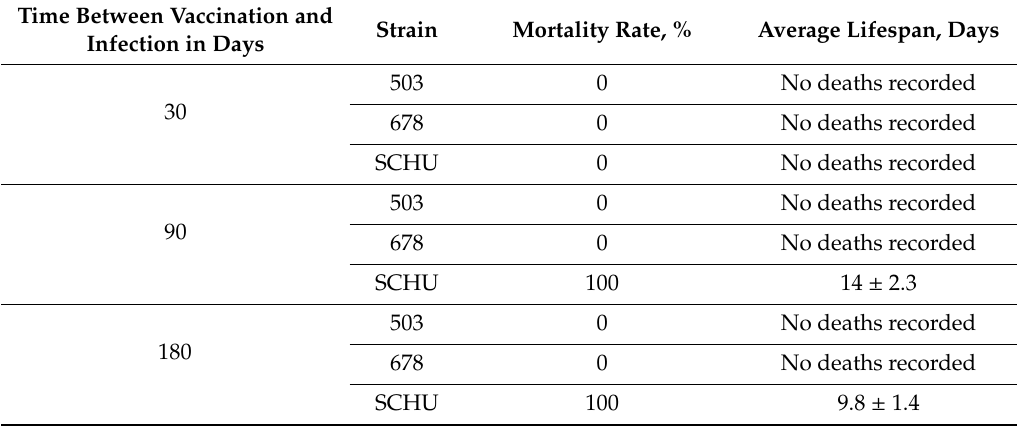
Table 4. Mortality and lifespan of immunized guinea pigs infected with virulent F. tularensis strains at di ff erent times after immunization. Values are indicated with the standard error of the mean (SEM). Time Between Vaccination and Strain Mortality Rate, % Average Lifespan, Days Infection in Days 503 0 No deaths recorded 30 678 0 No deaths recorded SCHU 0 No deaths recorded 503 0 No deaths recorded 90 678 0 No deaths recorded SCHU 100 14 ± 2.3 503 0 No deaths recorded 180 678 0 No deaths recorded SCHU